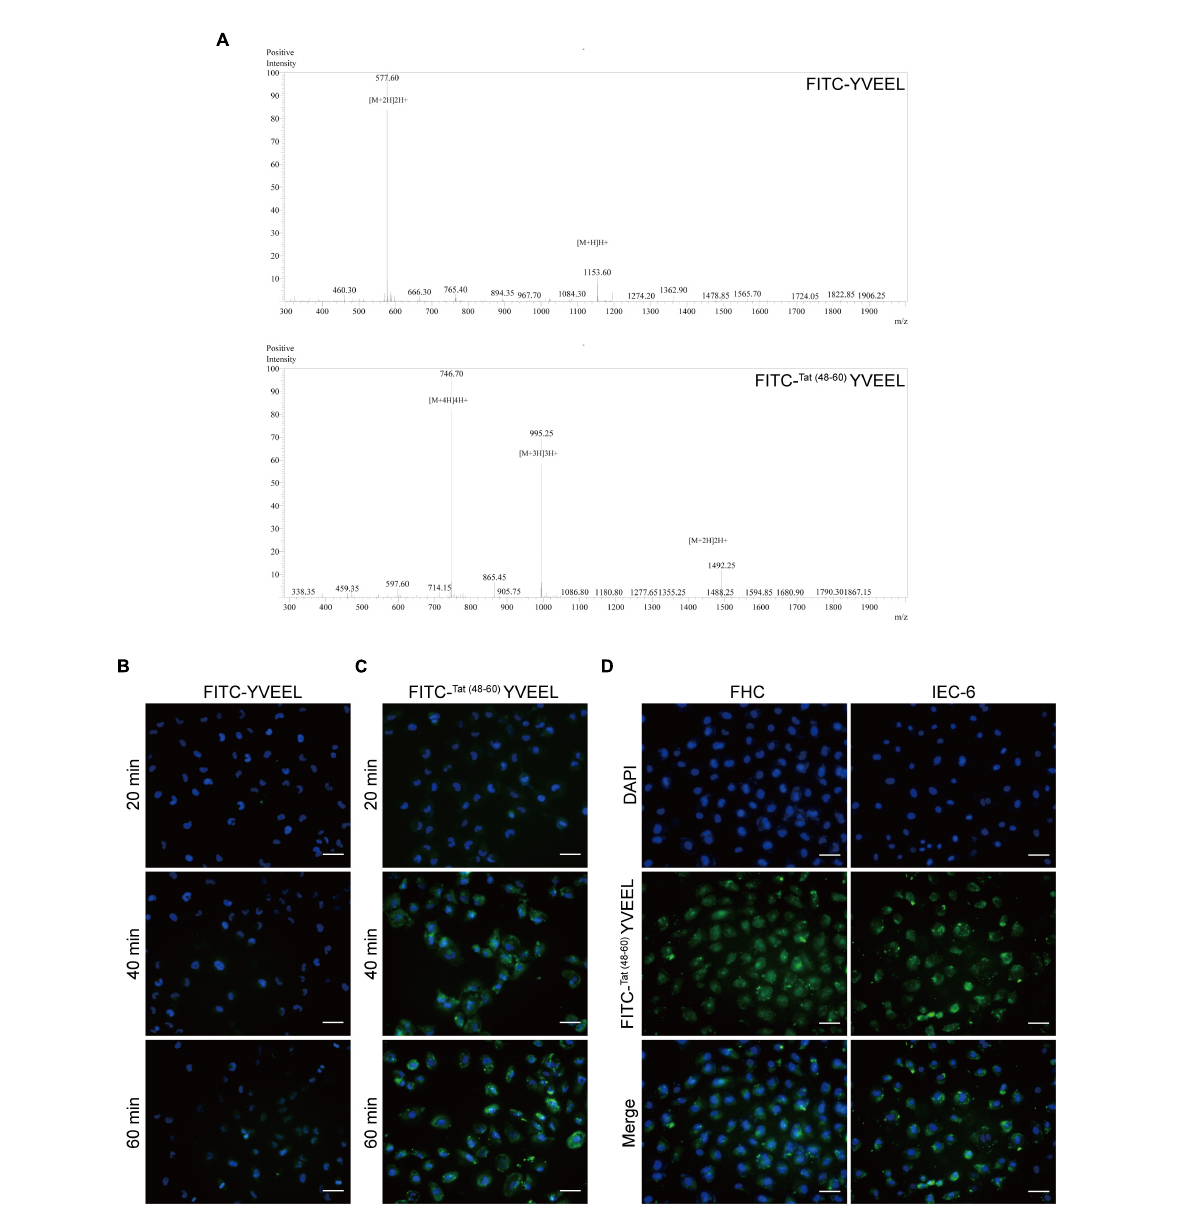
FIGURE1 Cellular entry of peptide YVEEL and the HIV-1 TAT (48–60) hybrid peptide. Peptide was labeled with FITC. (A) MS Spectrums of the indicated peptides; (B) microscopy images of FHC cells treated with FITC-YVEEL (20 µ M) for 20, 40, and 60 min, respectively; (C) peptide YVEEL was fused to HIV-1 TAT protein (48–60) and labeled with FITC [FITC- Tat ( 48 - 60 ) YVEEL]. Microscopy images of FHC cells treated with FITC- Tat ( 48 - 60 ) YVEEL (20 µ M) for 20, 40, and 60 min, respectively; (D) microscopy images of FHC and IEC-6 cells treated with FITC- Tat ( 48 - 60 ) YVEEL for 1 h at × 400 magnification. Nuclei were stained with DAPI (blue) before imaging. Bar = 50 µ